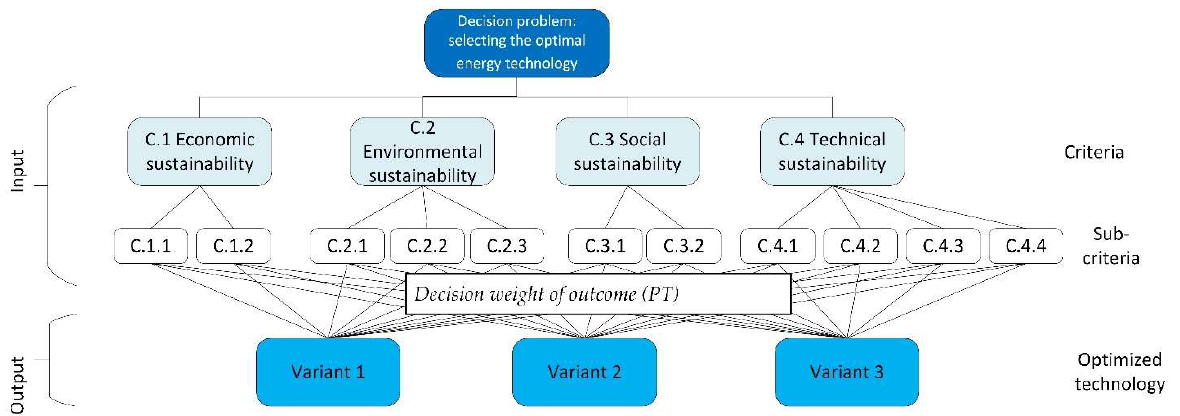
Figure 6. The hierarchy structure of the methodological approach: criteria, subcriteria and the alternatives.